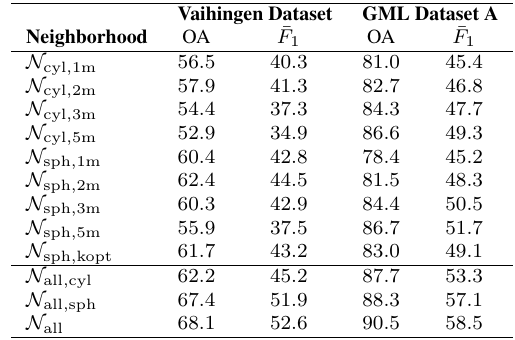
Table 3. OA and ¯ F 1 (in %) achieved for different neighborhood definitions on the Vaihingen Dataset and the GML Dataset A